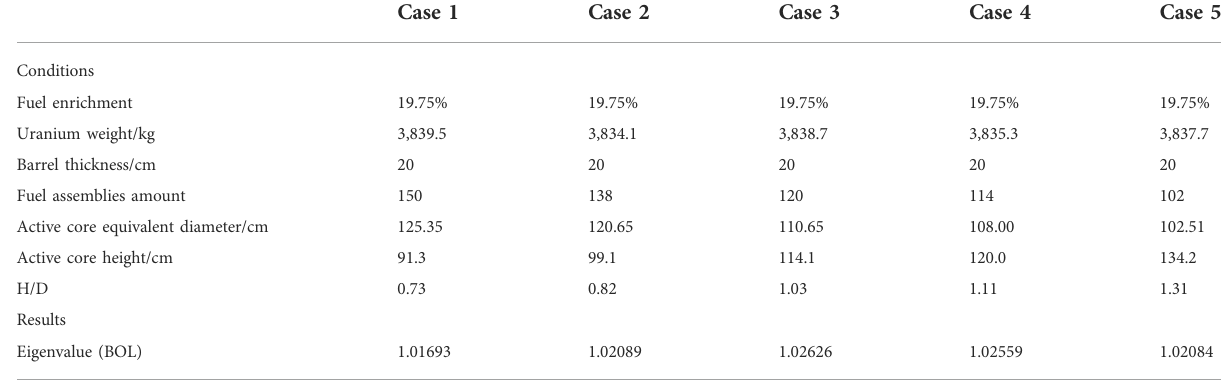
TABLE 2 Conditions and results of the height-to-diameter analysis.